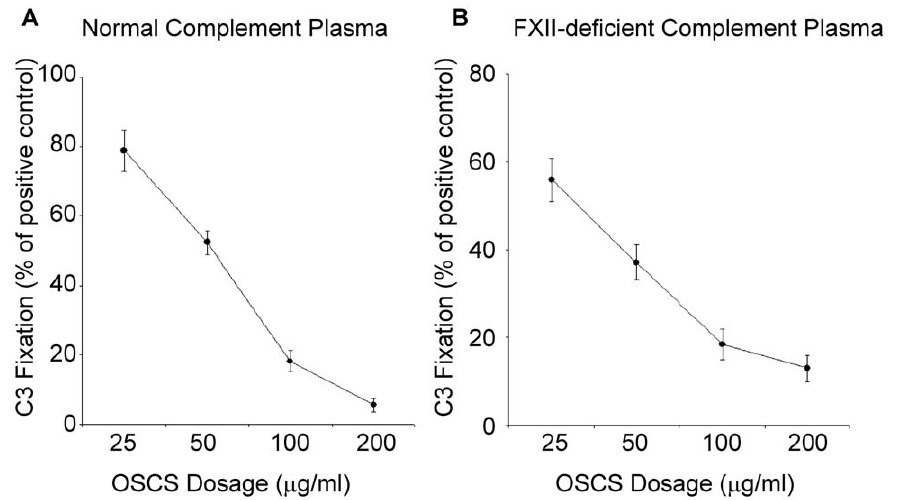
Figure 3. OSCS inhibits complement fixation in FXII-deficient plasma. 2E4-treated E.Coli BL21 bacteria were incubated with different doses of OSCS in the presence of (A) normal human plasma or (B) FXII-deficient human plasma. C3 Fixation was determined by anti-C3 binding and flow cytometry, and the percentage of C3 fixation was calculated as percentage of mean fluorescence intensity of the PBS-treated positive control samples. Data are representative of three independent experiments.